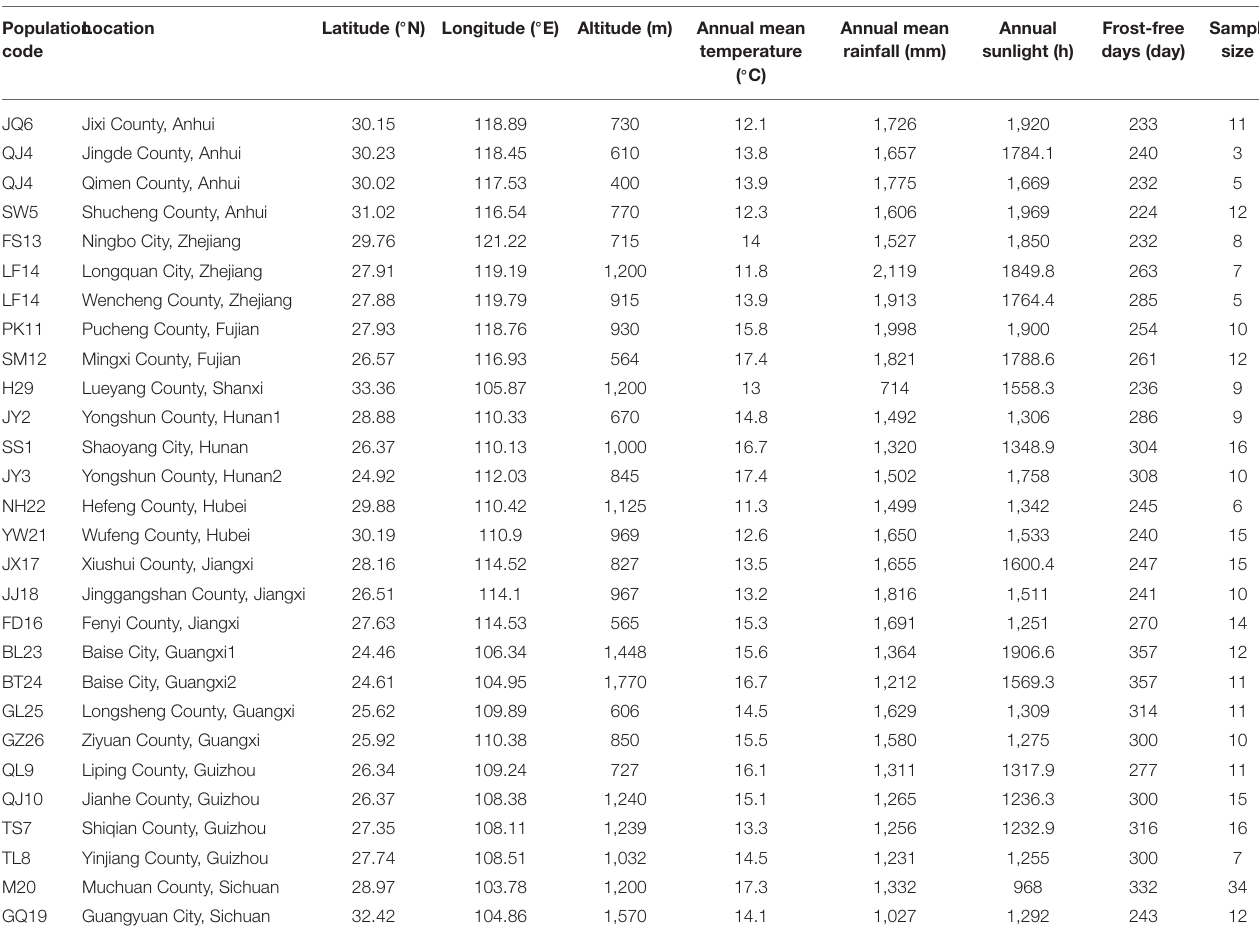
TABLE 1 | Collection locations and associated environmental factors. Population code